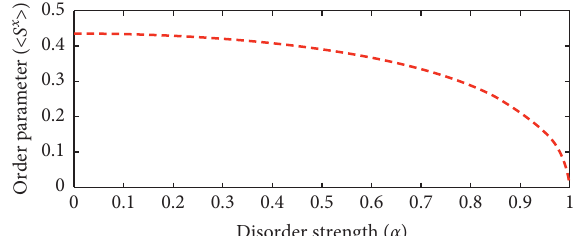
Figure 2: The behavior of superconducting order 〈 S x 〉 with in- creasing disorder strength α .